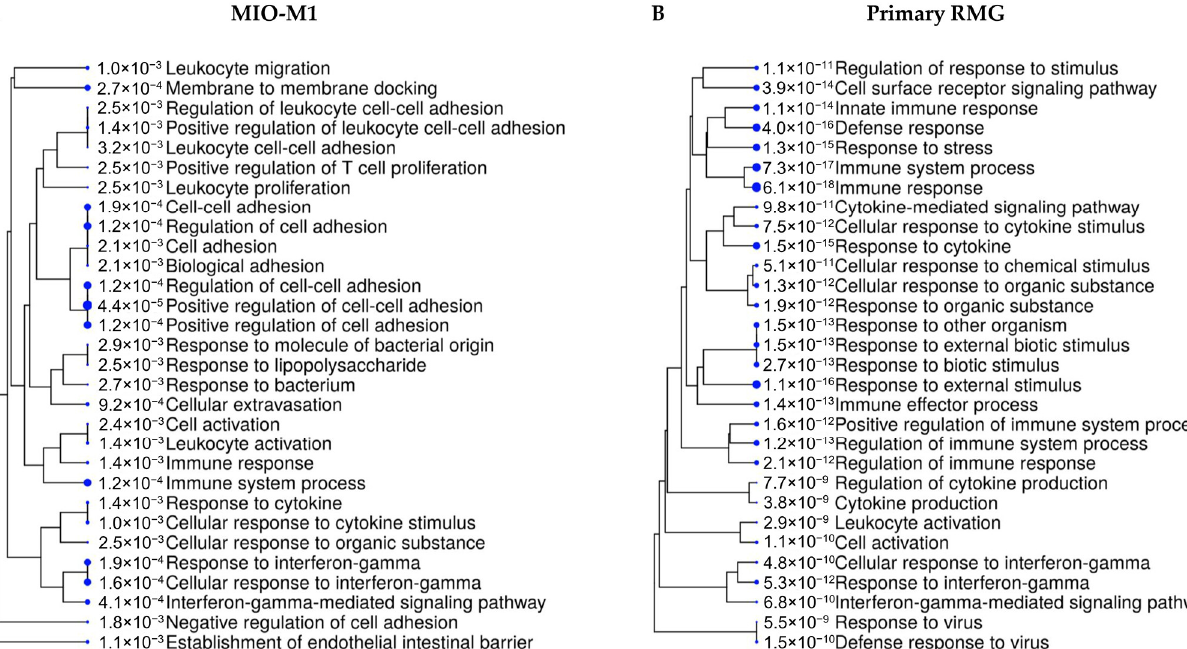
Figure 1. Volcano plot of all identified proteins in ( A ) MIO-M1 cells and ( B ) primary retinal Müller glial cells (RMG). ( A ) In MIO-M1 cells, 507 proteins were identified. Of those, 18 showed significantly ( p -value ≤ 0.05) higher abundance (fold change ≥ 2, green dots) after stimulation with LPS, while six proteins showed significantly lower abundance following LPS stimulation (fold change < 0.5, red dots). ( B ) of all 1425 identified proteins in primary RMG, 79 identifications were significantly more abundant (green dots), whereas 82 proteins were significantly less abundant (red dots) after LPS stimulation. Dotted blue lines indicate cut-off values for p-value and ratio. Proteins that were more abundant after LPS in both primary RMG and MIO-M1 cells are labeled with their human orthologue gene name in blue.